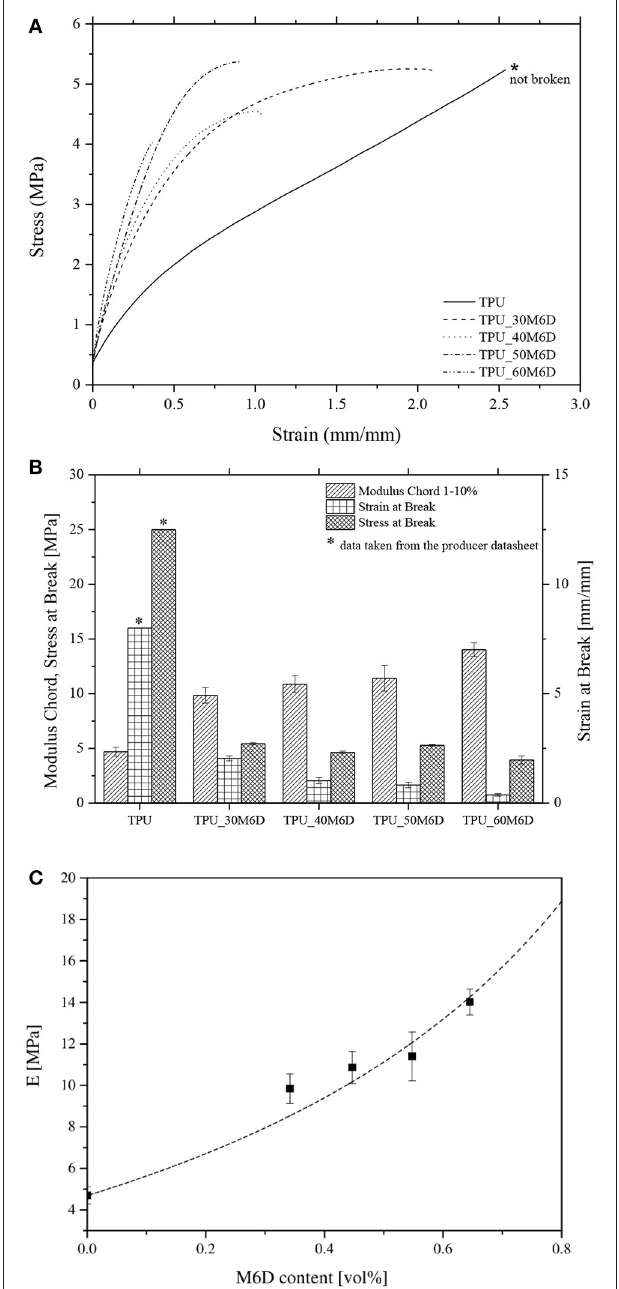
FIGURE 6 | Quasi-static tensile properties of neat TPU and relative blends. (A) Representative stress-strain curves, (B) elastic modulus and tensile properties at break, (C) fitting of elastic modulus data with Halphin Tsai model (microcapsules elastic modulus = 28.4 MPa).